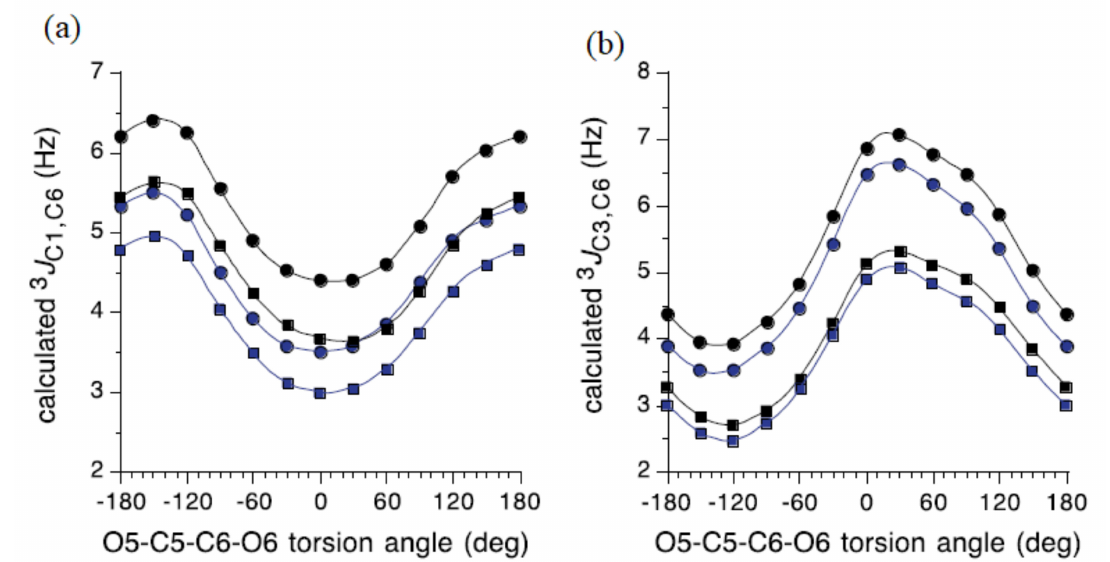
Figure 27. ( a )—The effect of the exocyclic CH 2 OH conformation on calculated 3 J (C-1,C-6) coupling constant in the model carbohydrates 51 (blue circles), 52 (black circles), 53 (blue squares), and 54 (black squares); ( b )—The effect of the exocyclic CH 2 OH conformation on calculated 3 J (C-3,C-6) values, same symbols. Reproduced from Bose-Basu et al. [134] with the permission of the American Chemical